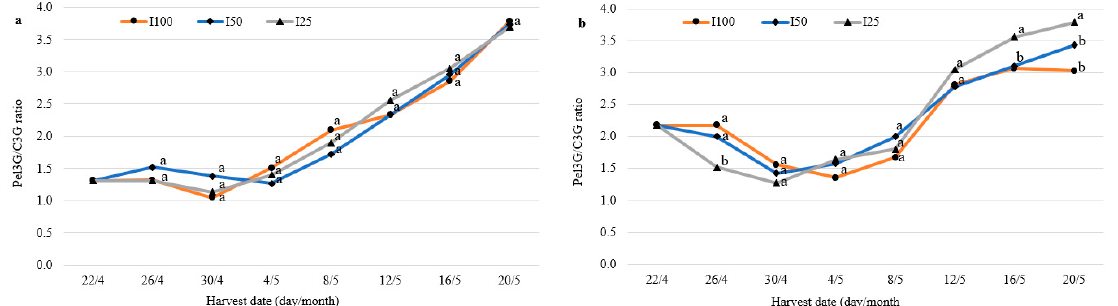
Figure 3. Pel3G/C3G ratio in the berries of wild strawberry “Rojan” ( a ) and No. 17 ( b ). Plants were fully irrigated (I100) and irrigated with half (I50) and a quarter (I25) of full irrigation. Data followed by the same letter are not significantly different according to the LSD test at p ≤ 0.05.